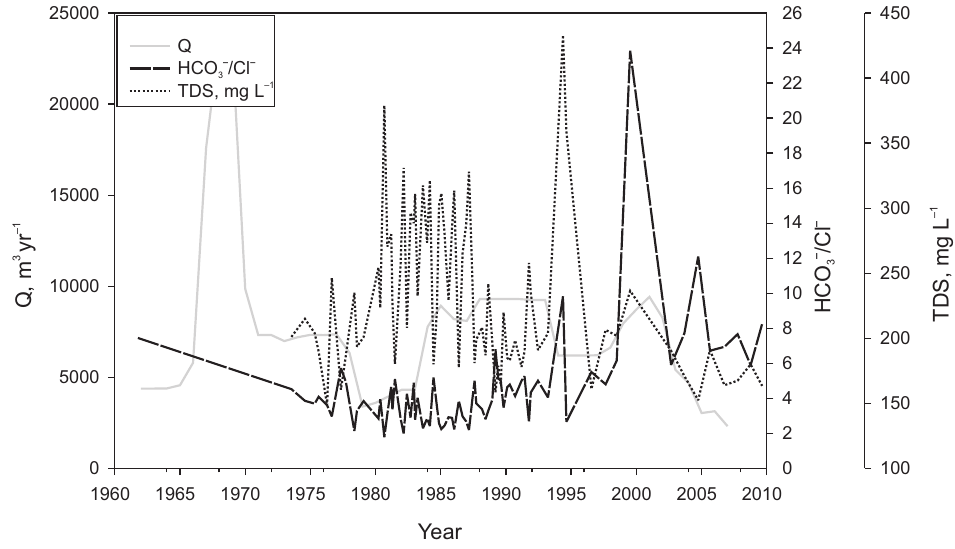
Fig. 10. Change in HCO 3 (cid:150) /Cl (cid:150) values in well